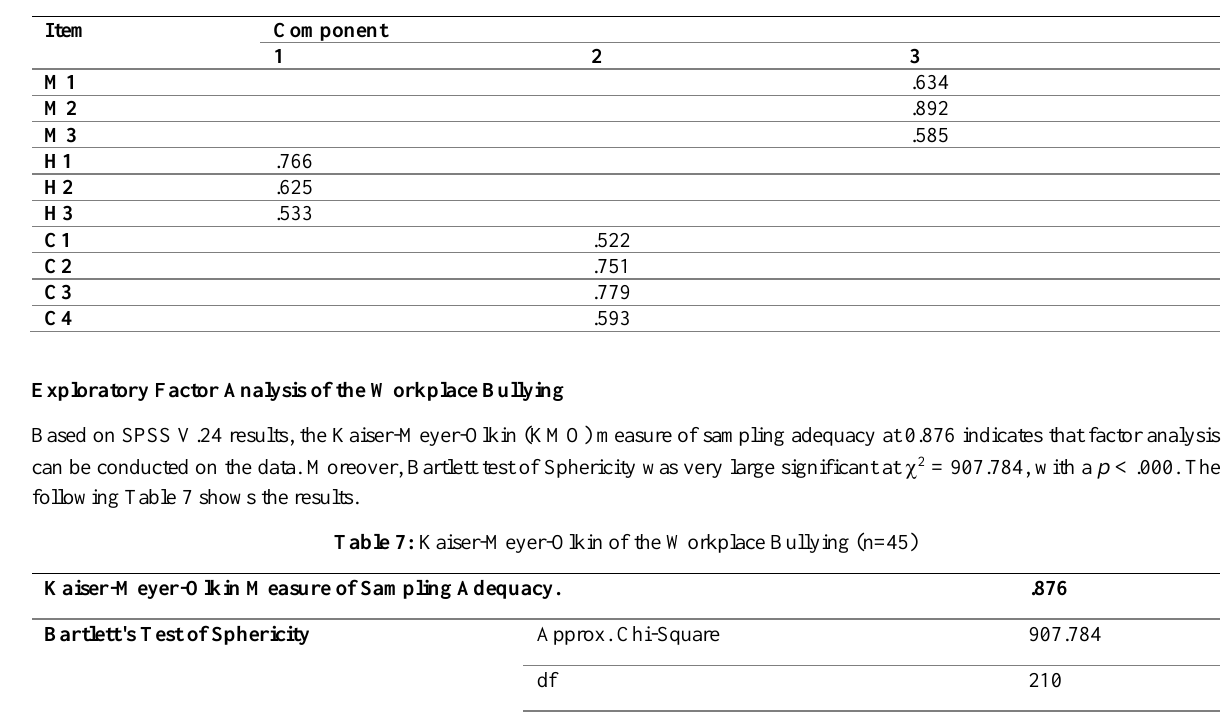
Table 6: Exploratory Factor Loadings of the Resonant Leadership (n=45)